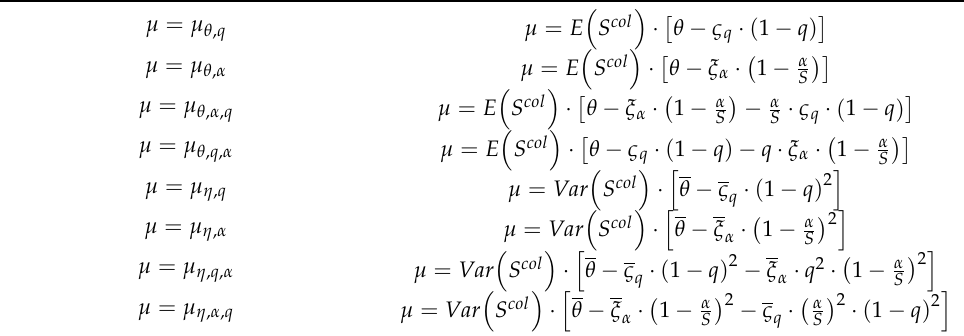
Table 6. Specification of the parameter µ